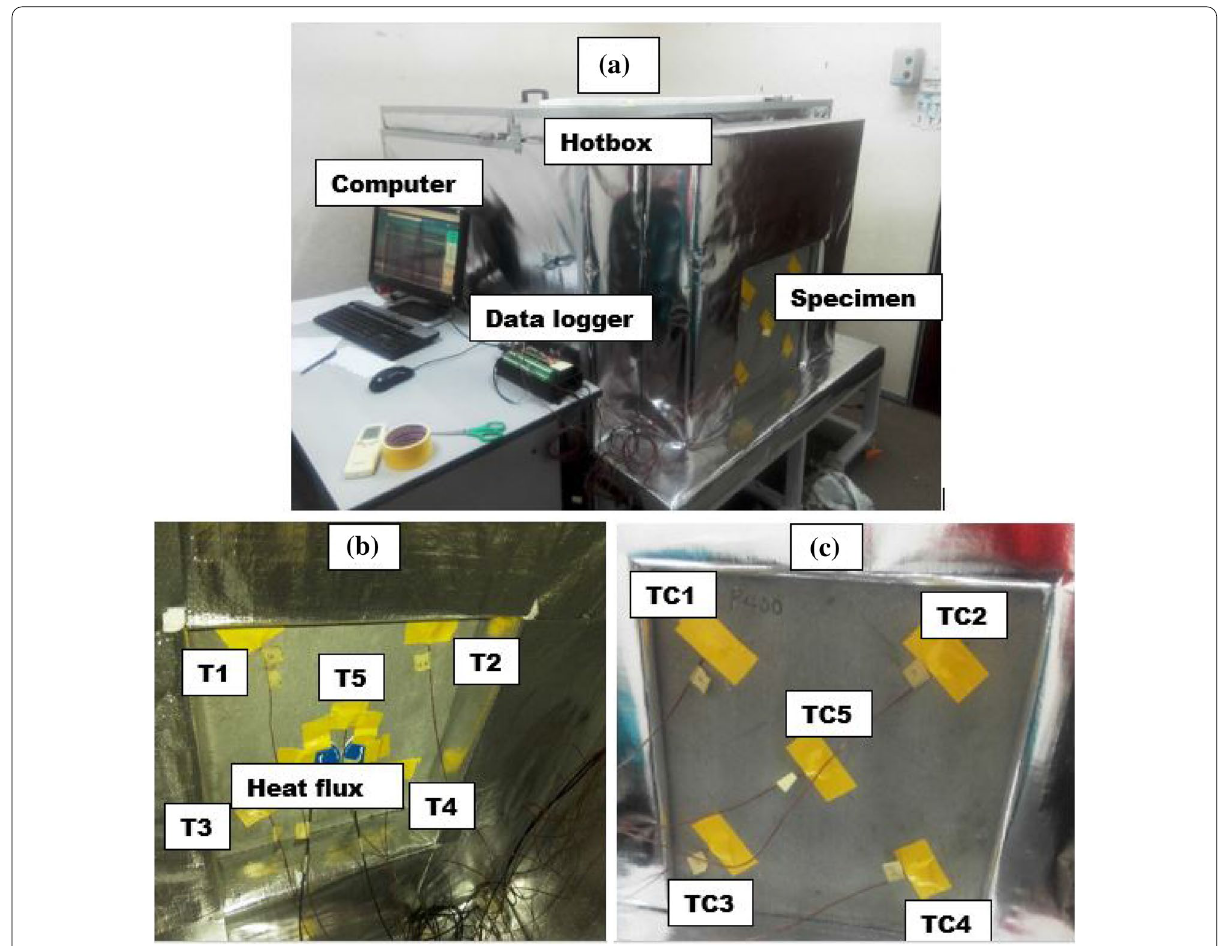
Fig. 4 Experimental setup a Hotbox apparatus b hot and c cold surfaces of the